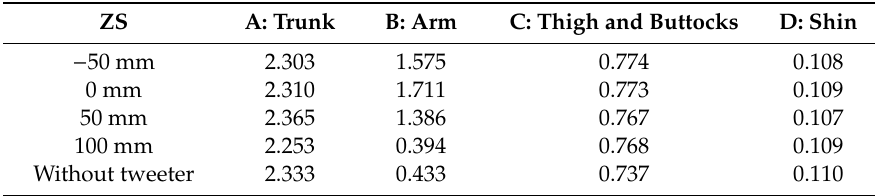
Table 7. Maximum electric field strength (mV/m) variation in different measurement positions with the z -direction=adjusted tweeter in the aluminum vehicle.